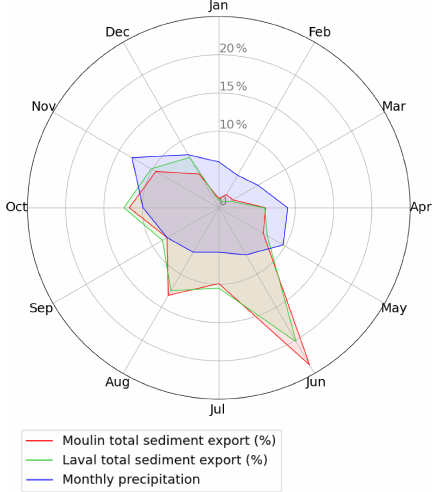
Figure 5. Comparison of the relative distribution of monthly sed- iment export for the Laval and Moulin catchments, together with relative monthly rainfall distribution.